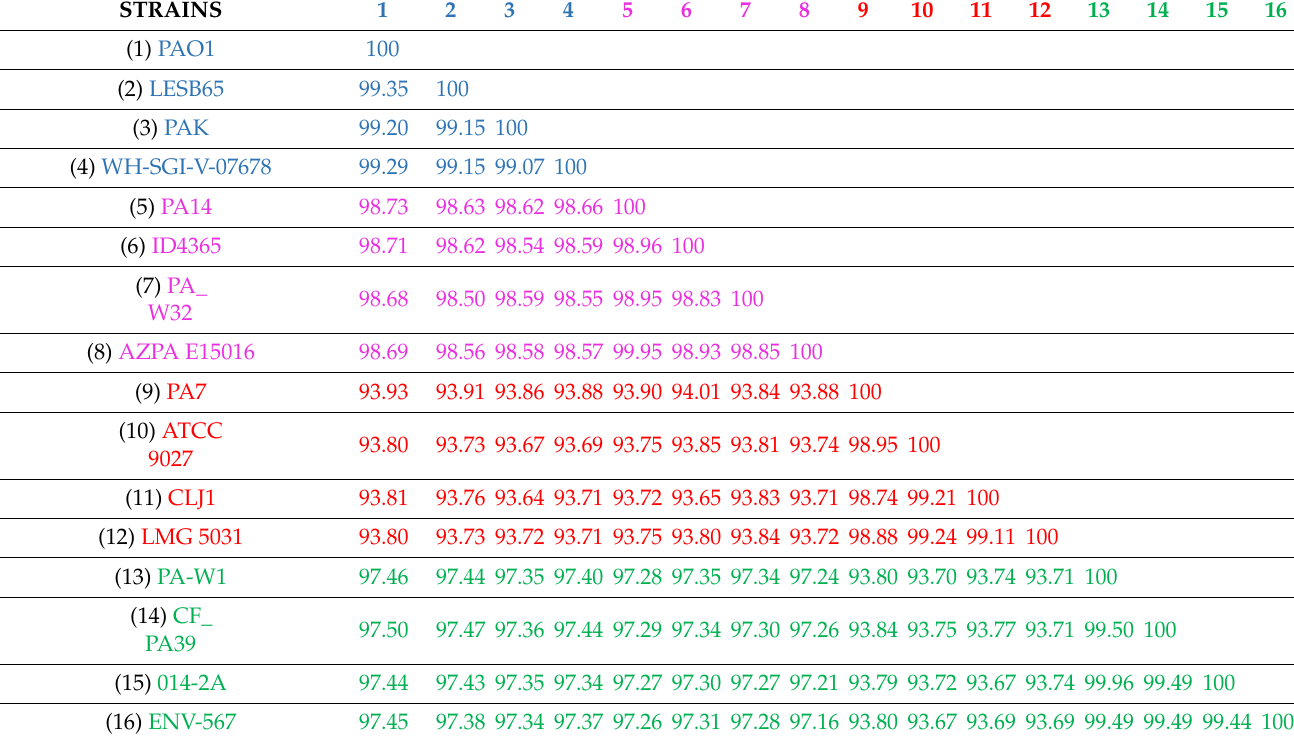
Table 2. Average nucleotide identity (ANI) of some genomes belonging to phylogroups 1 (blue), 2 (pink), 3 (red), and 5 (green)